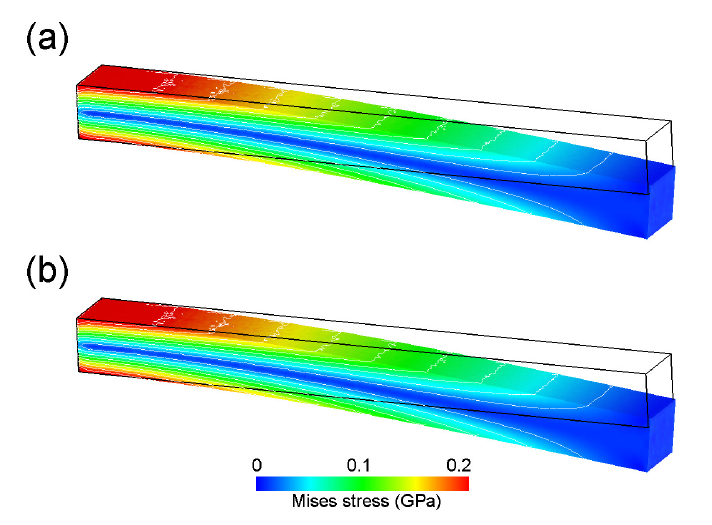
Figure 3. Spatial distribution of von Mises stress. The results of ( a ) QDEM and ( b ) FEM show the stress in the steady state at 2 s after loading began. The displacement is shown with a magnification of 2000 ×